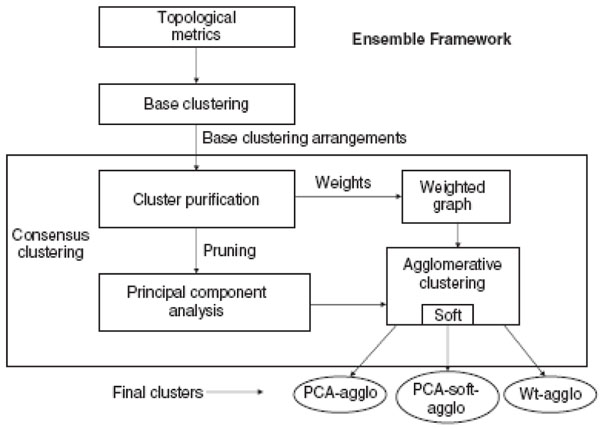
Overview of the ensemble framework[108]